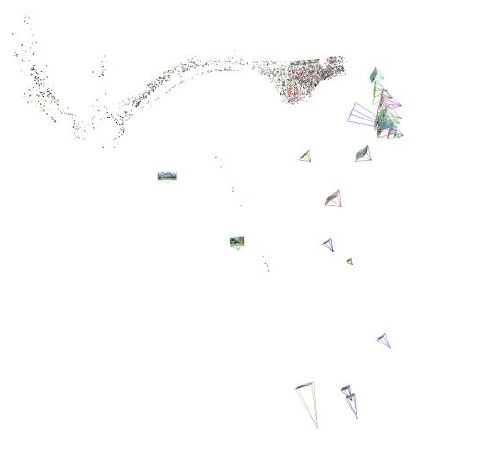
Figure 6: Viewpoint distribution.